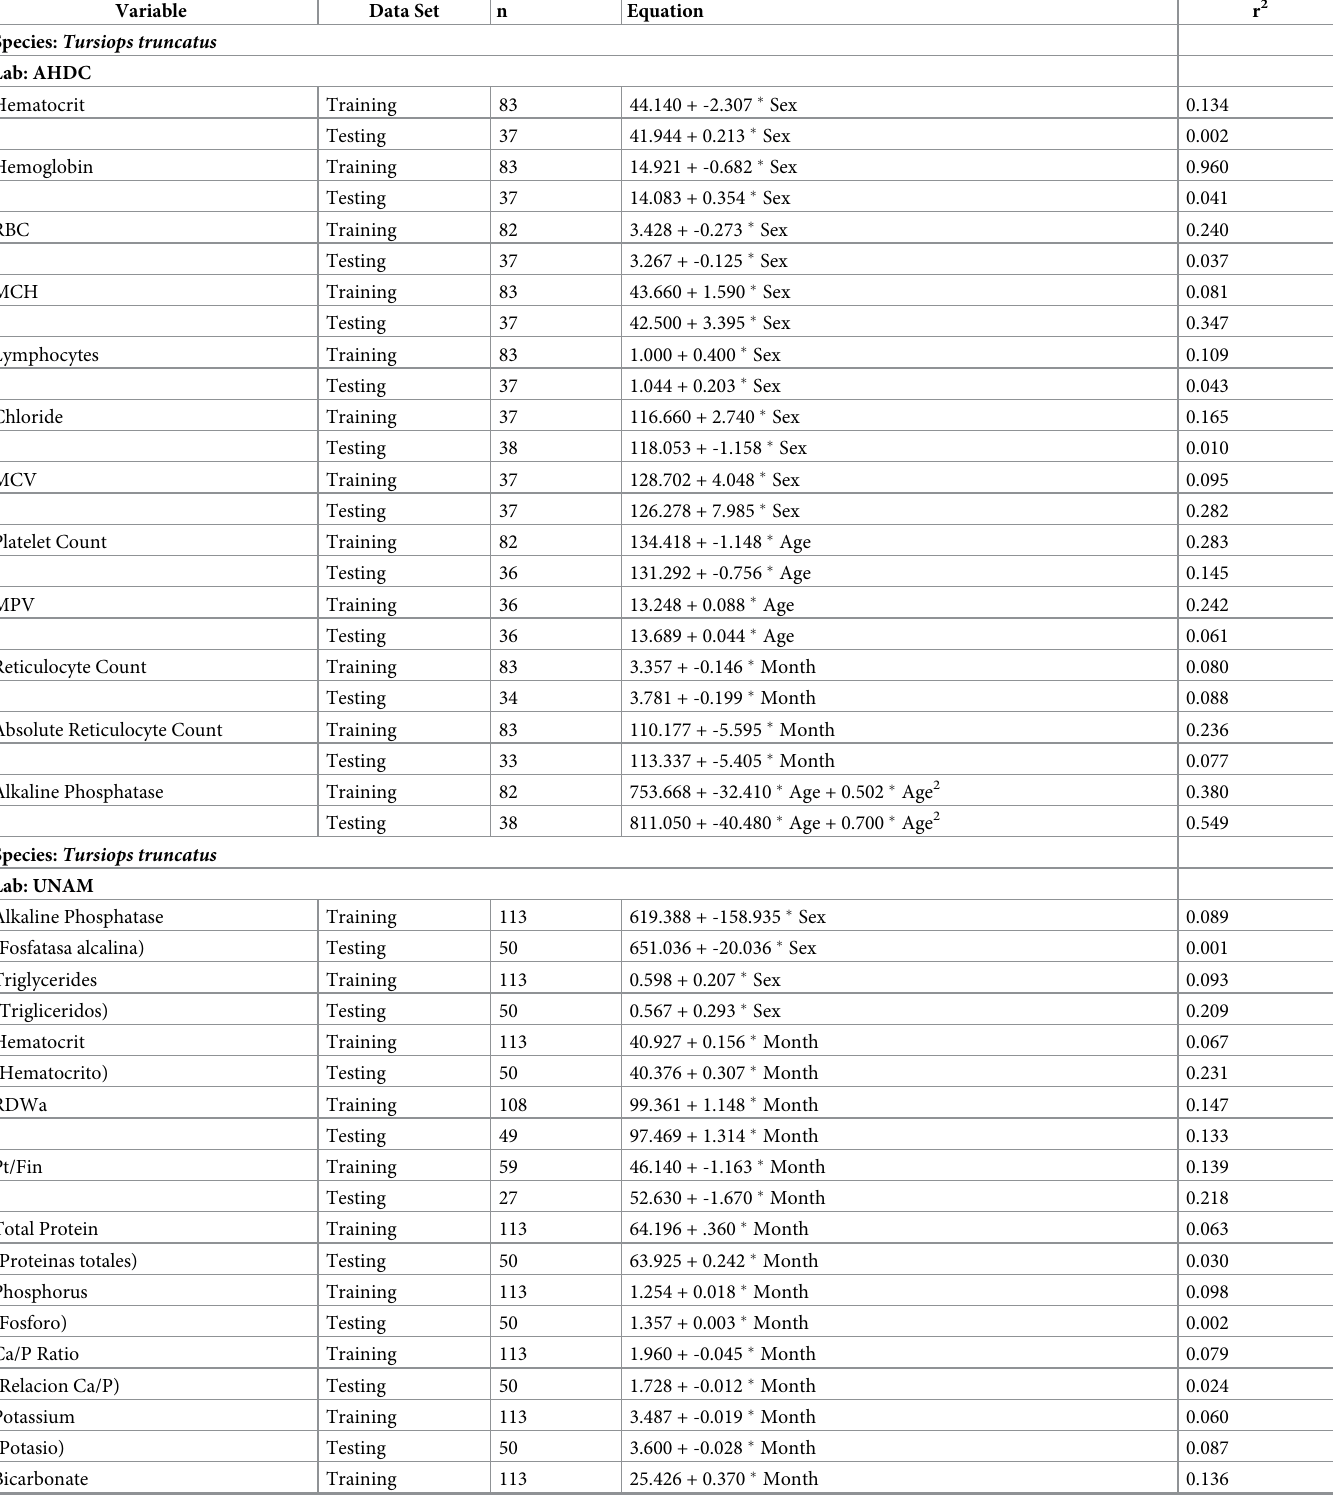
Table 1. Fit of predictions on training and testing datasets from linear regression